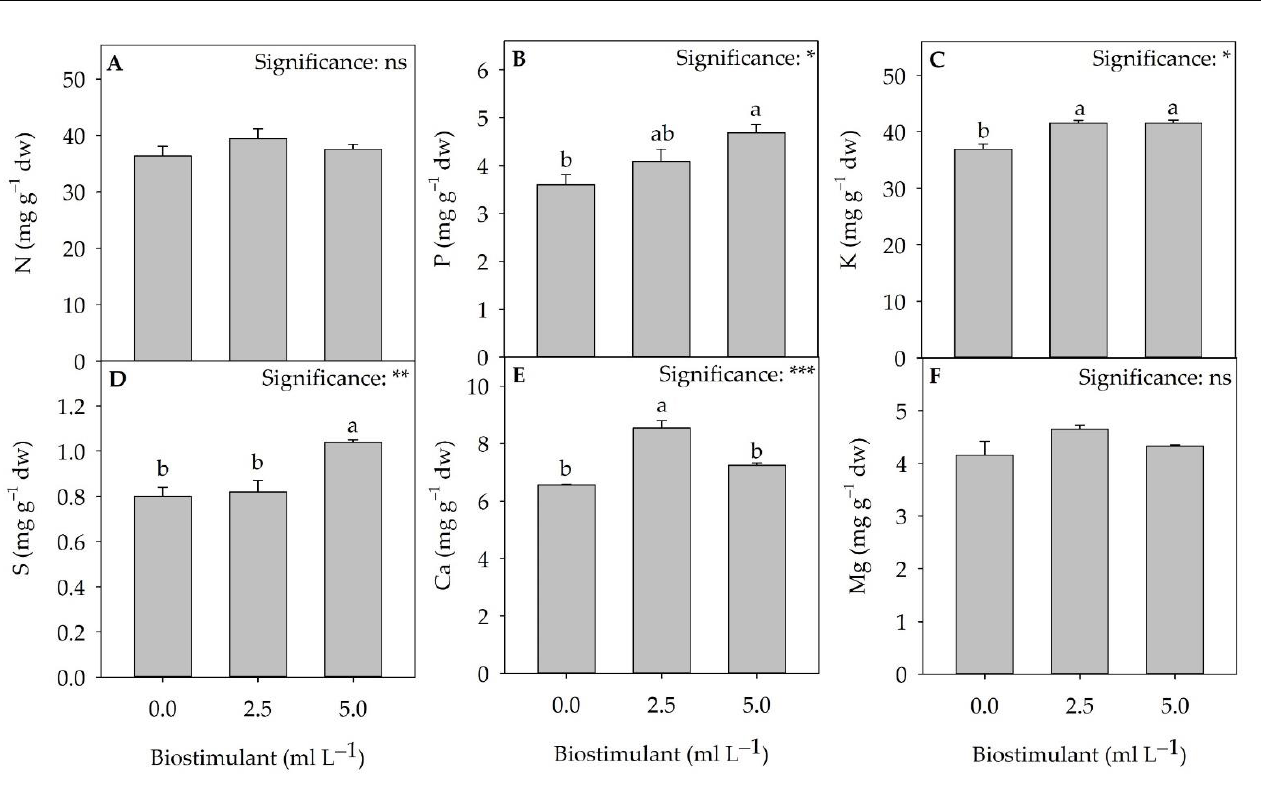
Figure 2. The analysis of variance and mean comparisons for nitrogen ( A ), phosphorus ( B ), potassium ( C ), sulfur ( D ), calcium ( E ), and magnesium ( F ) of greenhouse lettuce cultivated under three biostimulant doses. ns, *, **, and *** indicate non-significant or significant difference at p < 0.05, p < 0.01, and p < 0.001, respectively. Different letters indicate statistically different groups according to the Tukey HSD post-hoc test ( p = 0.05). Data are mean values ± standard error, n = 3.